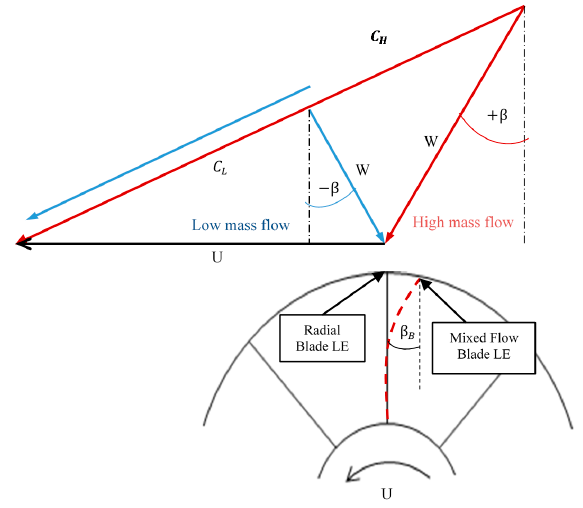
Figure 2. Rotor inlet velocity triangles under pulsating flow.